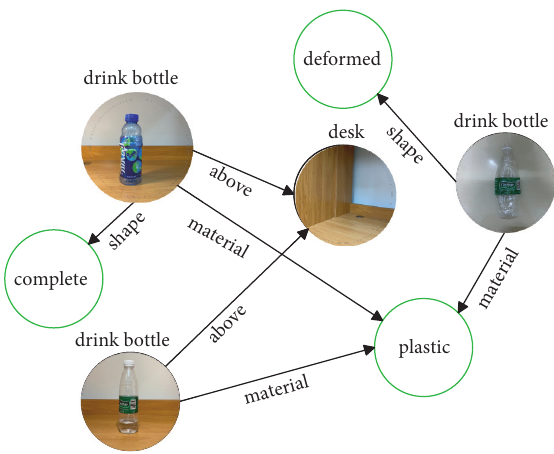
Figure 4: Knowledge graph